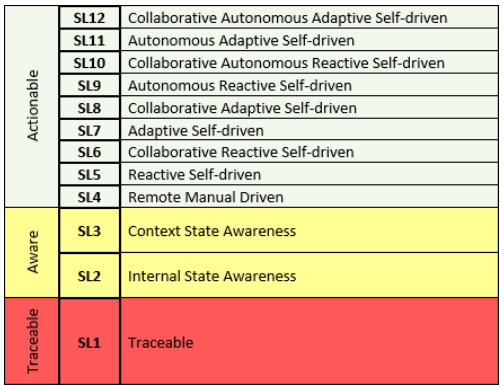
Figure 1. Evolutionary set of capabilities, growing from bottom to